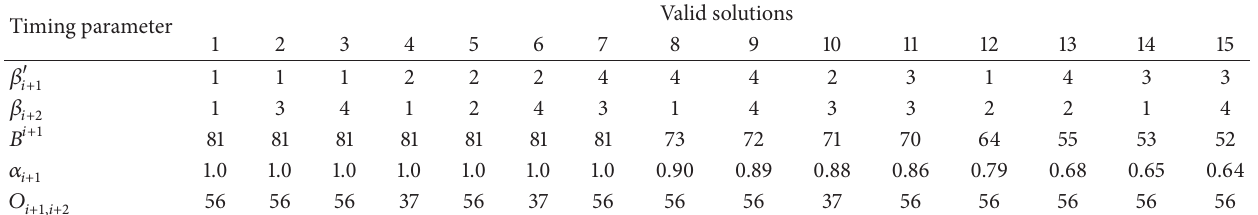
> 𝐺 , Mill Street and Vassar Street). IBT ,𝑖+2 IBT ,𝑖+1